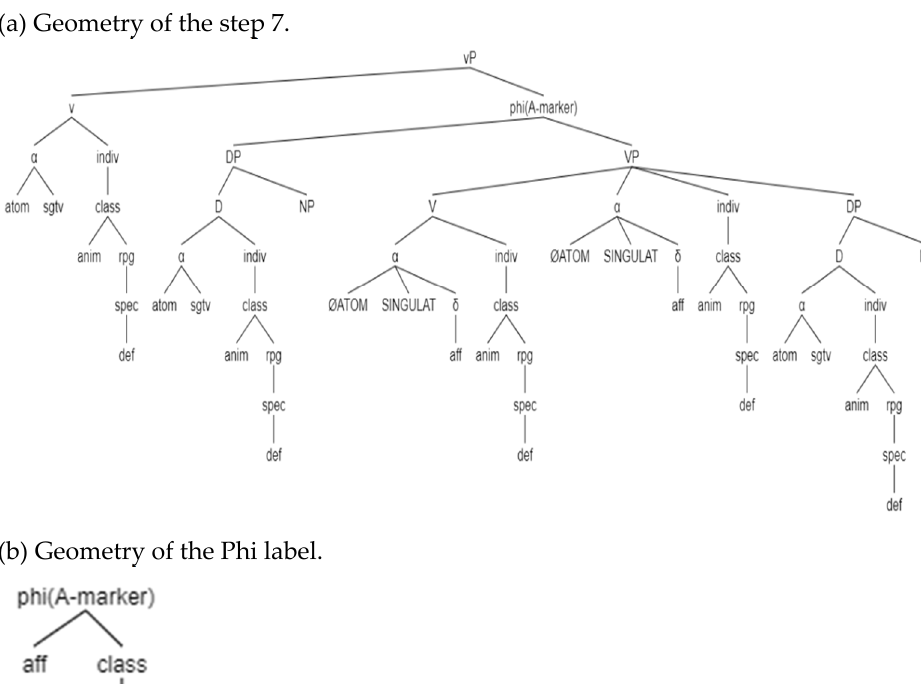
Figure 17. Geometries with labels.